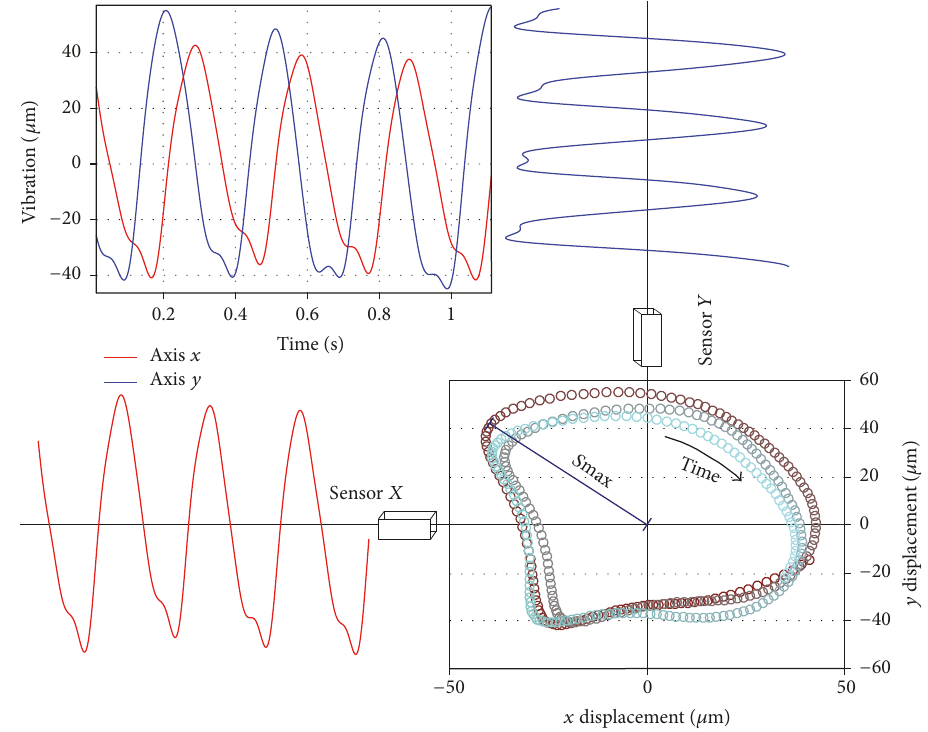
Figure 1: Sensors displacement and